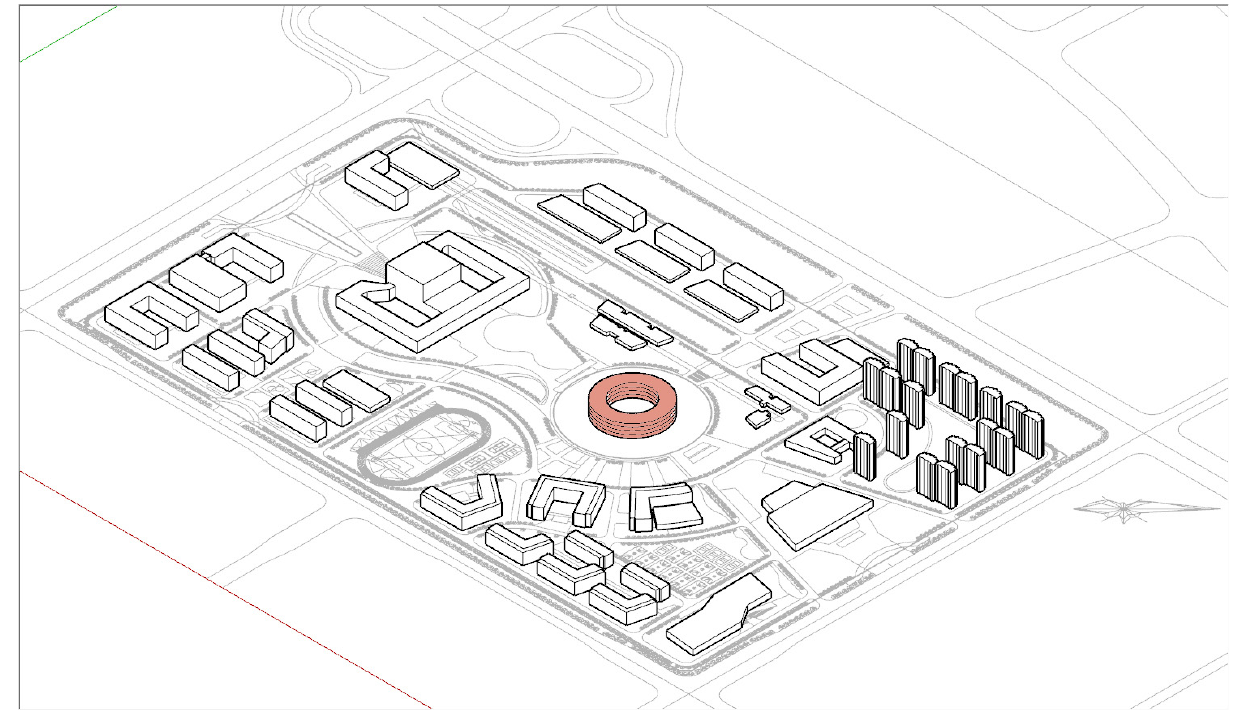
Figure 1. The campus library model (self-developed).